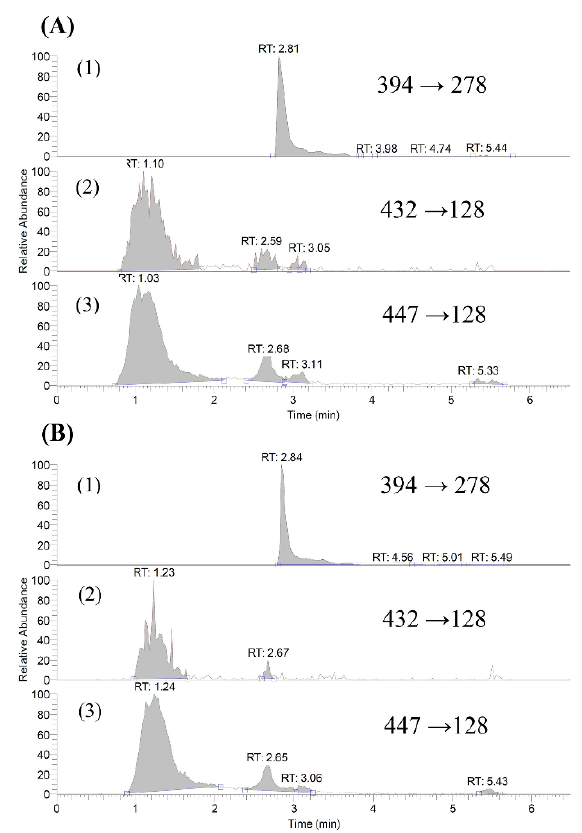
Figure 1. LC-MS/MS chromatograms: ( A ) blank serum spiked with erlotinib (1, internal standard), O -desmethyl gefitinib (2) and gefitinib (3); ( B ) a serum sample obtained at 240 min after a dose of gefitinib.